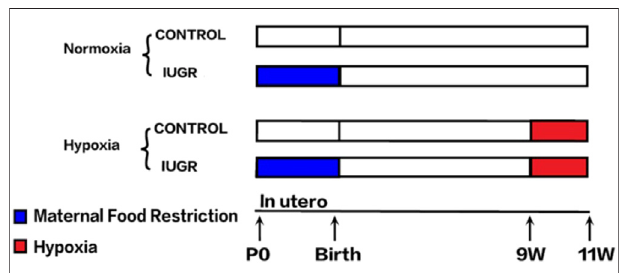
FIGURE 1 | Flowchart of the experimental